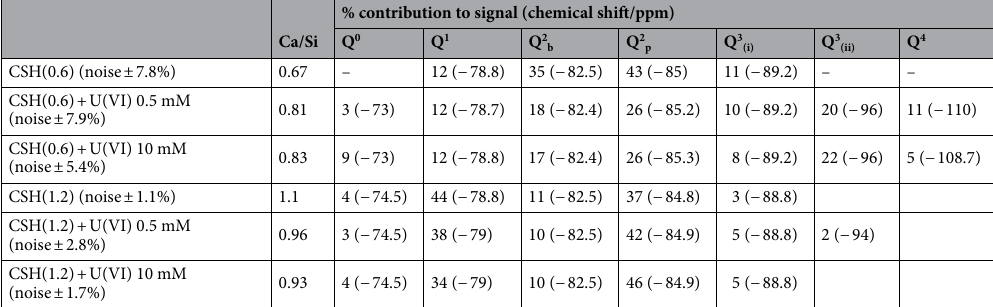
are edge-sharing with one pentagonal uranyl unit of one uranyl chain (2 × U) and vertex-sharing with another uranyl unit (1 × U) of the adjacent uranyl chain, to form uranyl-silicate sheets 38 . Weeksite (K 2 (UO 2 ) 2 Si 6 O 15 ·4H 2 O) exhibits Q 4 and Q 4 (2U) species and demonstrates pentagonal bipyramidal uranyl chains, where the Q 4 (2U) species are edge sharing with one pentagonal uranyl unit (2 × U) to form the uranyl-silicate sheets. The sheets are connected by vertex-sharing Q 4 species (connected to three Q 4 (2U) species and one further Q 4 species). Haiweeite (Ca[(UO 2 ) 2 Si 5 O 12 (OH) 2 ]·3H 2 O), shown in Fig. 8b, exhibits Q 3 and Q 4 (2U) species. The Q 4 (2U) spe- cies are also edge-sharing with pentagonal bipyramidal uranyl units (2 × U), as in weeksite. The Q 3 species are then vertex-sharing with three of the Q 4 (2U) species, but unlike in weeksite (and as these are Q 3 species), the sheets are not connected 25,39 . Uranophane and weeksite could, therefore, account for the observations of singular Q 3 (ii) and Q 4 species, respectively. Given that the haiweeite structure exhibits both Q 3 and Q 4 species, this could account for the observed signals in the 29 Si MAS-NMR spectra for the CSH(0.6) phases. The formula of the Ca 2 (UO 2 ) 2 Si 6 O 15 ·10H 2 O